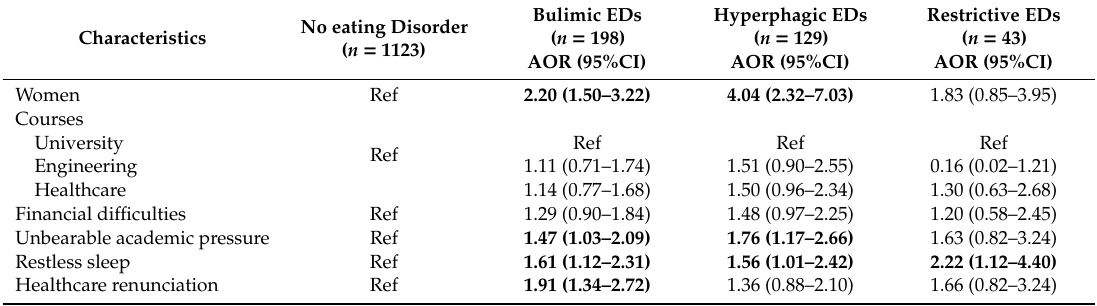
Table 2. Factors associated with eating disorder diagnostic categories (logistic regression). Characteristics